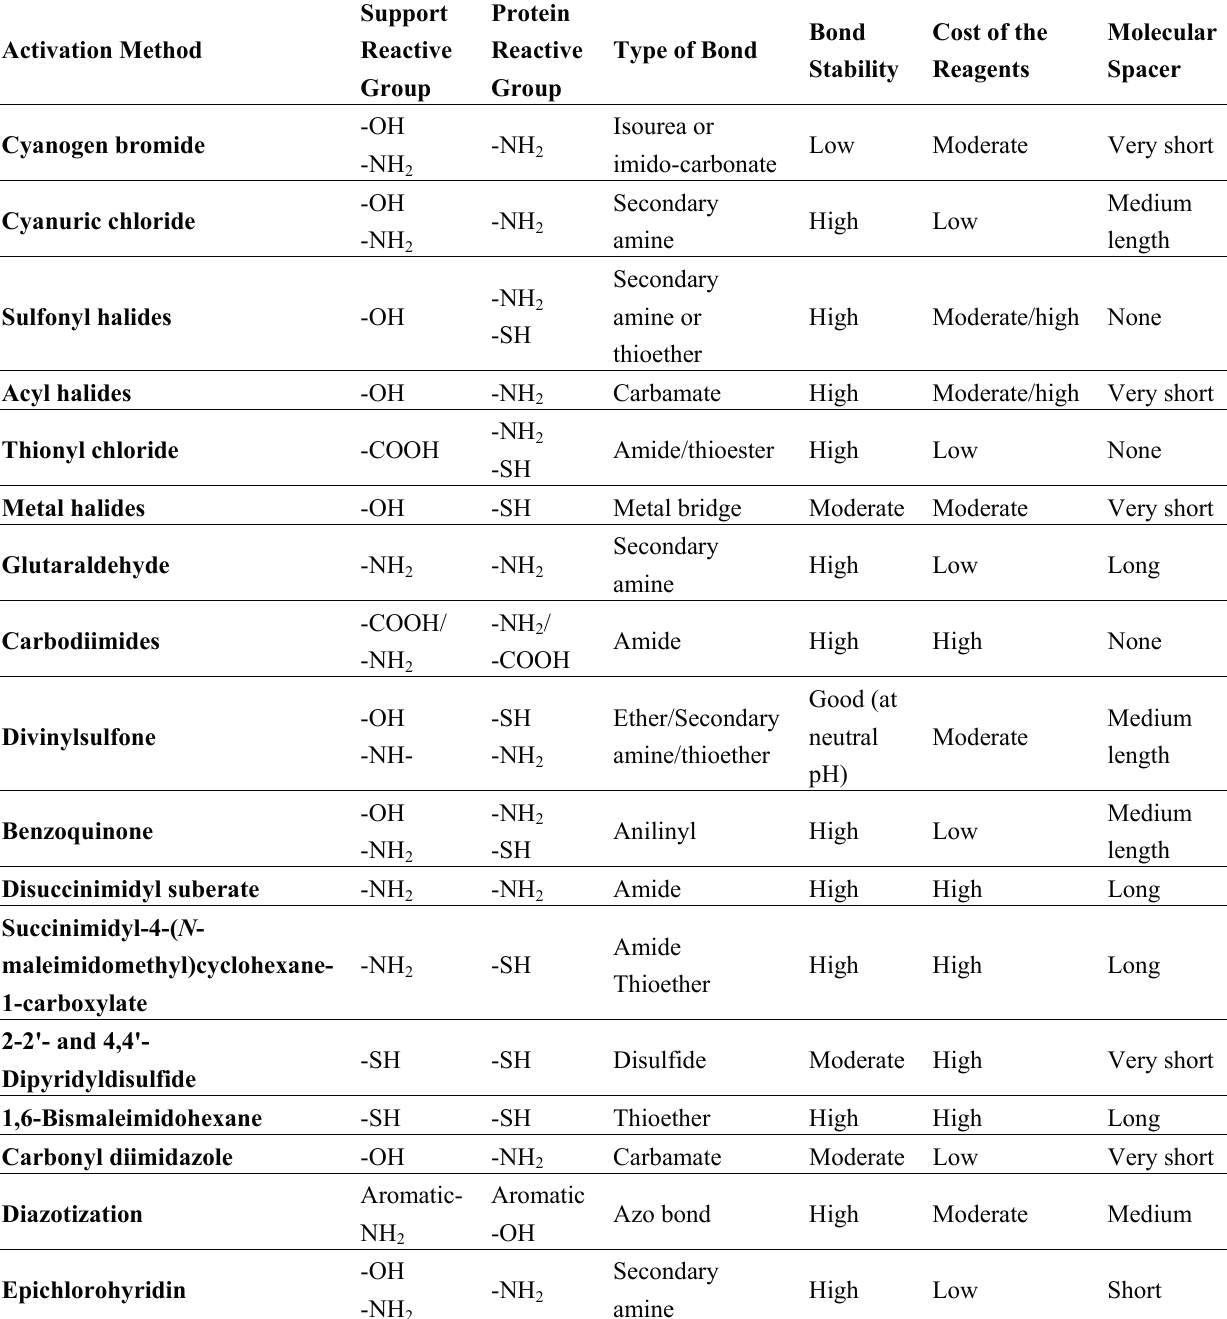
Table 2. Summary of the most common methods of activation for inorganic